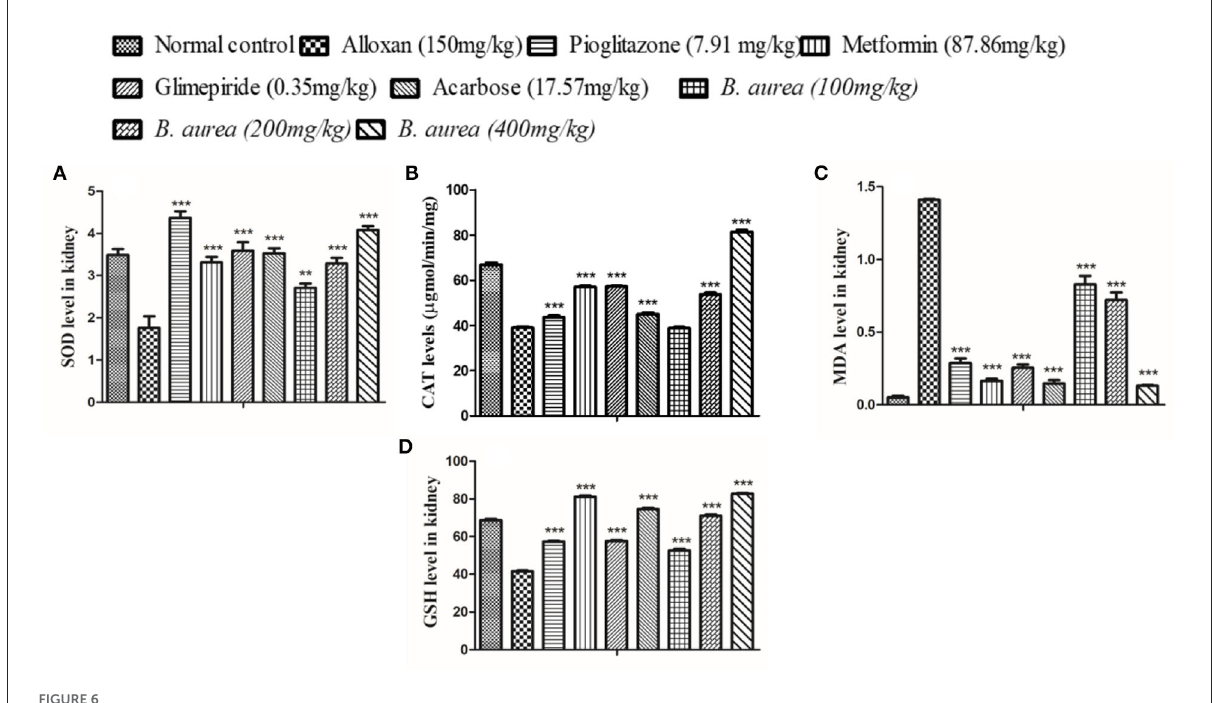
FIGURE6 Effect of B. aurea on antioxidant enzyme level in the kidney of diabetic animals. (A) superoxide dismutase (SOD), (B) catalase (CAT), (C) melanoaldehyde (MDA), and (D) reduced glutathione (GSH). *** p < 0.001, ** p < 0.01, * p < 0.05 significant